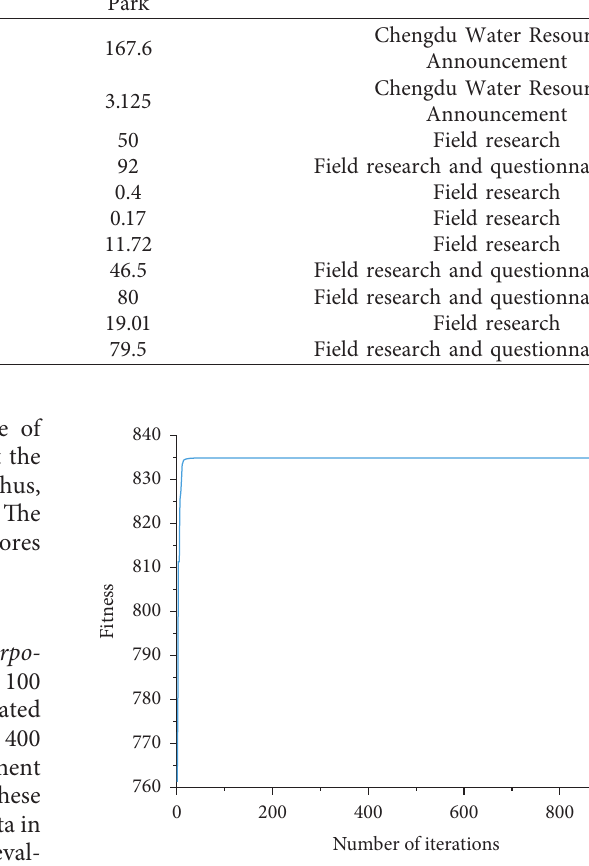
Figure 2: The convergence curve of the PPM optimized by